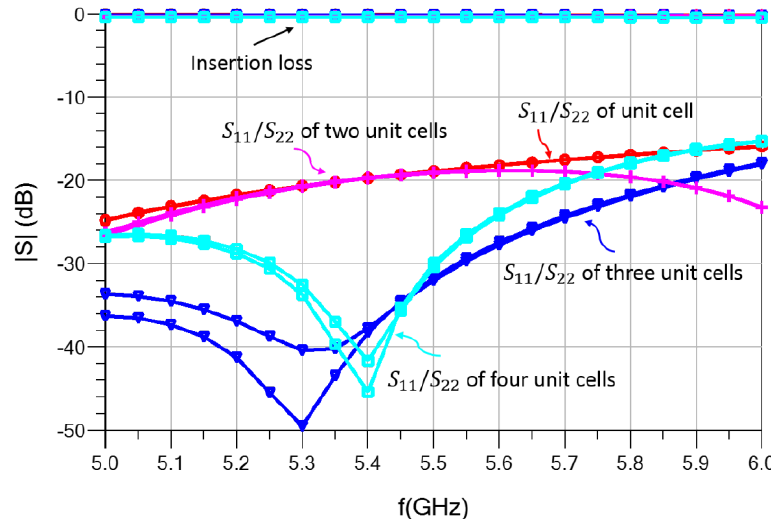
Figure 6. Simulated S parameter results of the proposed unit cell and cascaded unit cells P-CRLH phase shifter with MRSs embedded on the symmetrical stubs using −90 ° unit cell phase shift.